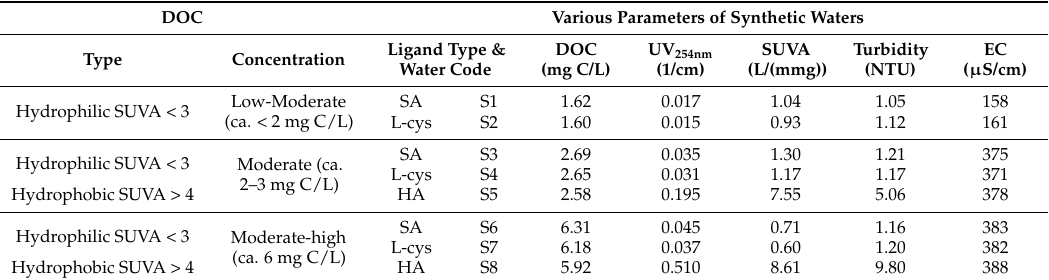
Table 1. The composition of the synthetically prepared